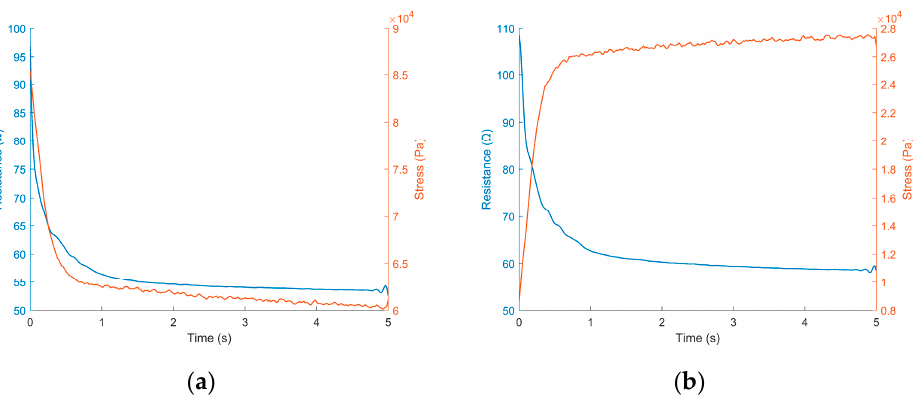
Figure 7. Stress–relaxation (orange) and transient resistance response (blue) during stress relaxation